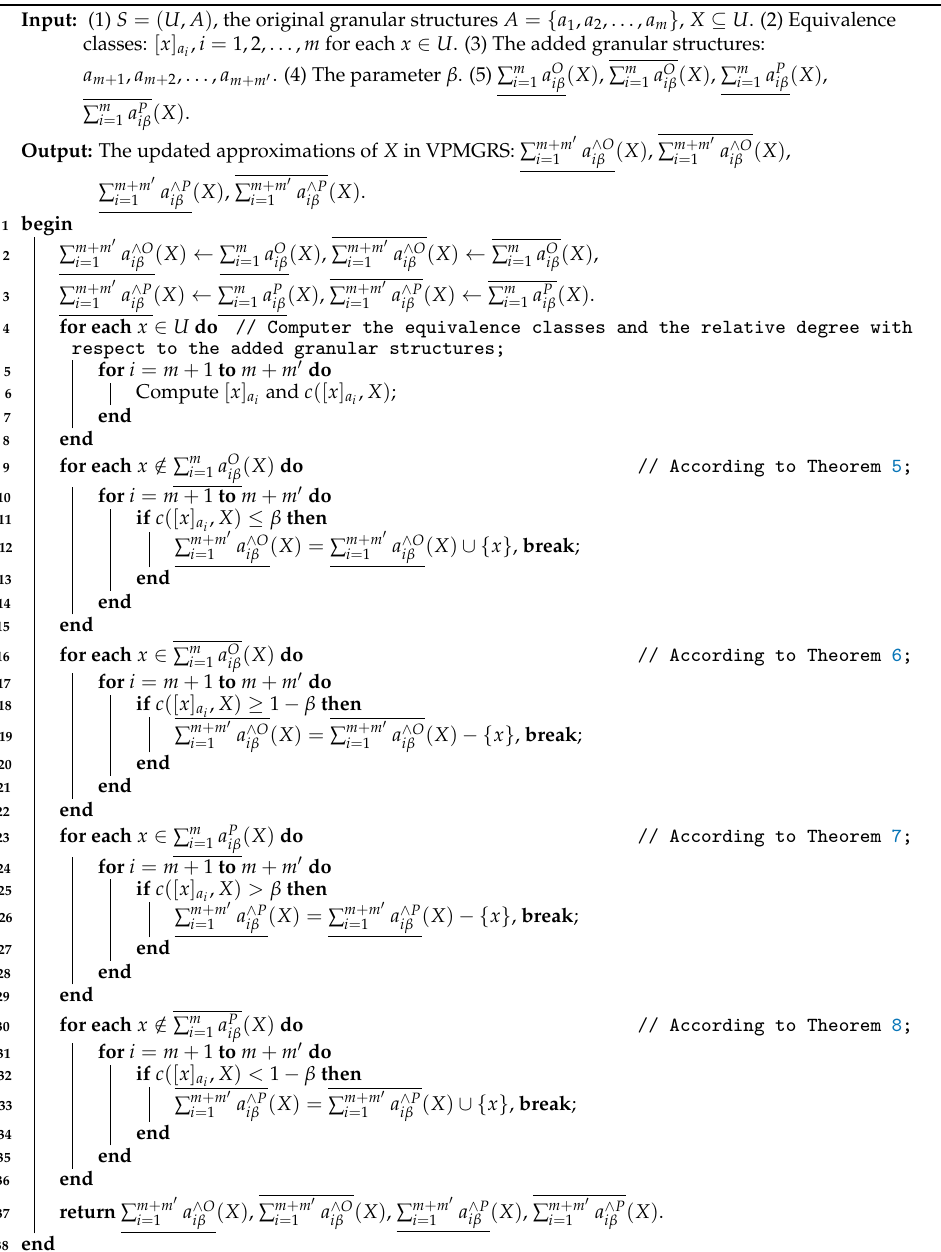
Algorithm 2: An incremental algorithm for updating approximations of VPM- GRS while adding multiple granular structures